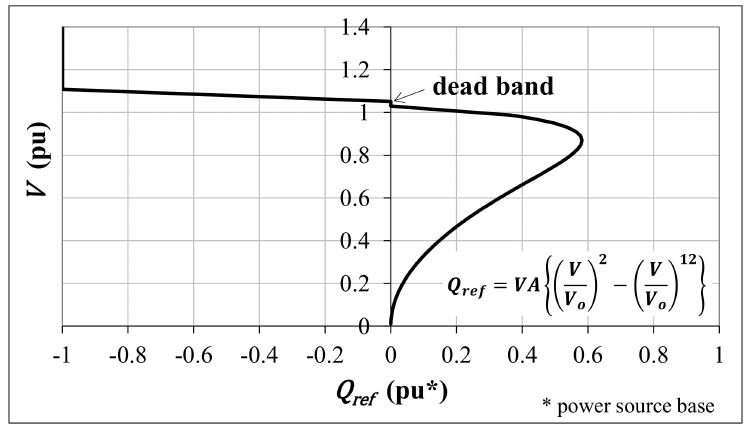
Figure 3. Reactive power control model (voltage–reactive power characteristic).